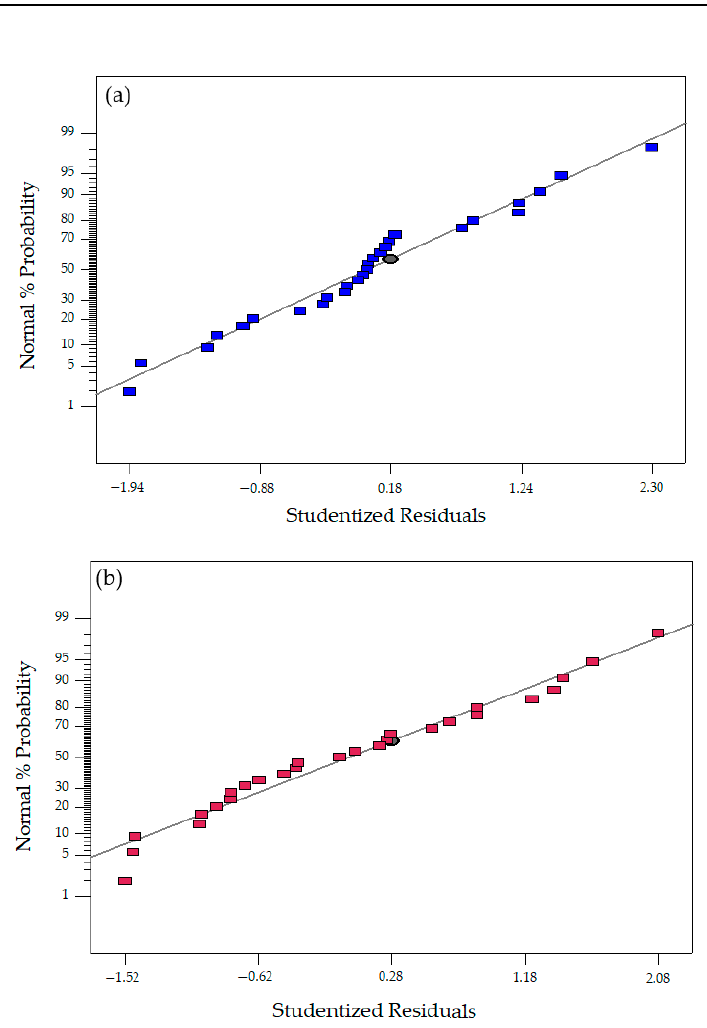
Figure 5. The plot of normal probability of residuals: ( a ) shear strength and ( b ) peel